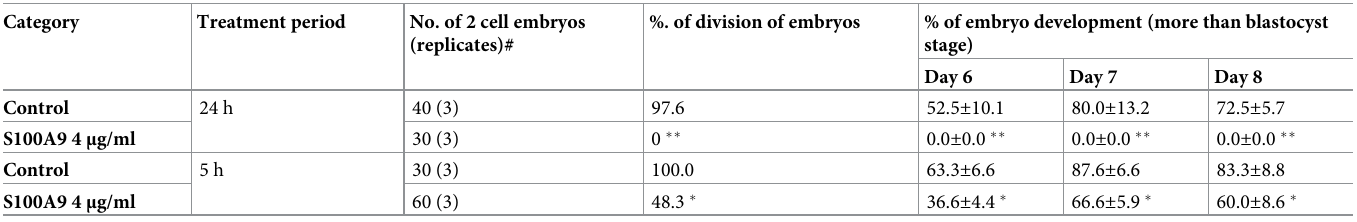
Table 3. Time-dependent effect of S100A9 on 2 cell stage fertilized embryos.